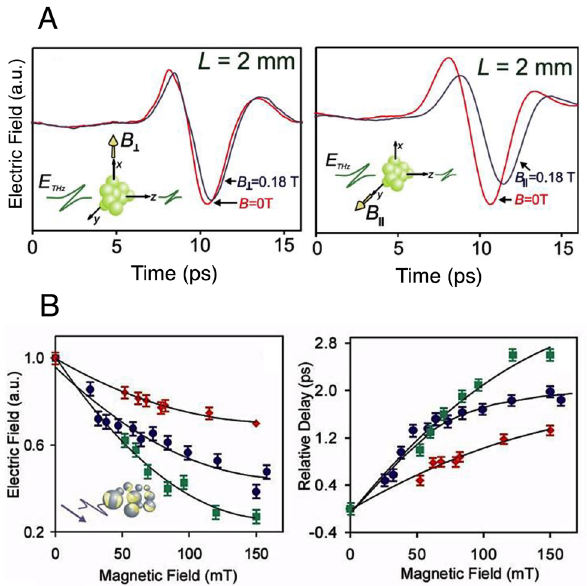
Figure9: THzspinplasmonicsingranularsystems.(A)Timedomain transmittedTHzwaveformsthrougha2mmthicksampleof74 μ mCo particles for different values of the magnetic fi eld applied parallel (right panel) or perpendicular (left panel) to the polarization of the pulse. From ref [91], https://doi.org/10.1103/PhysRevLett.96. 033903, with permission. (B) Normalized THz electric fi eld amplitude(leftpanel)andmagnetic fi eldinduceddelay(rightpanel) of the THz pulse transmitted through Co particle ensembles having different Au surface coverages versus magnetic fi eld strength for a magnetic fi eld applied parallel to the polarization of the pulse. Au surface coverage: 0% (red diamonds), 35% (blue circles) and 42%( greensquares).From ref [93], https://doi.org/10.1103/PhysRevLett. 98.133901, with